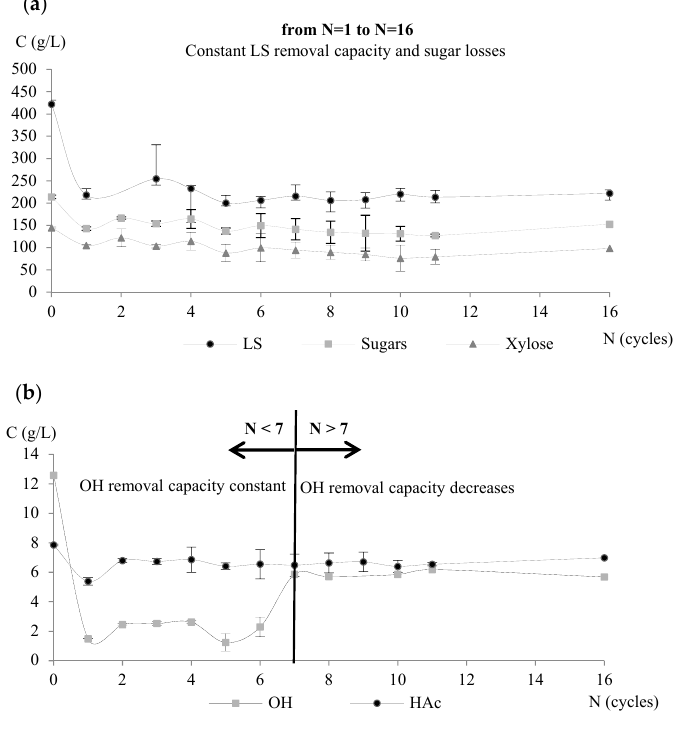
Figure 4. Sequential use of anionic resins: ( a ) Evolution of LS and sugars; ( b ) evolution of phenolics and acetic acid.